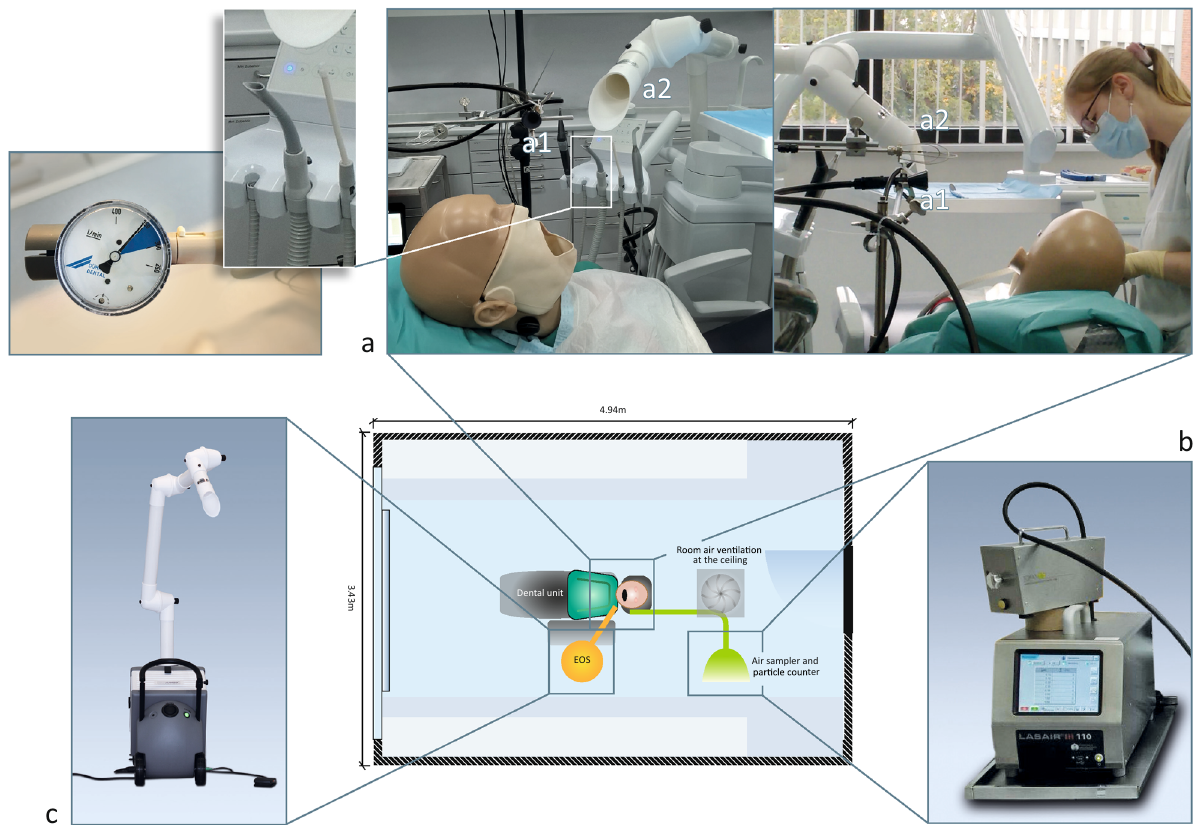
Fig. 1 Overview of the experimental setup in the treatment room. a Dental unit equipped with a manikin head (Kavo, Biberach, Germany) and a high- fl ow suction system (Du ̈ rr, Bietigheim-Bissingen, Germany) with a 16-mm intraoral cannula and a saliva ejector (left magni fi cation; the calibrated fl ow rate was ≥ 350 l/min at the 16-mm intraoral cannula; Du ̈ rr, Bietigheim-Bissingen, Germany). a1 Air sample point of the particle counter (Lasair III 110 cleanroom, PMS Inc., USA), sensor for the air velocity and a2 suction tube of the mobile extraoral scavengers (EOS; JakAir Mobile System, ULT, Löbau, Germany) 0.35 m above the mouth of the manikin head. b Monitor of the particle counter. c View of the EOS device. The EOS device and the air sample point of the particle counter were placed at the same level/distance from the open mouth of the manikin head and the head of the investigator before each test (0.35